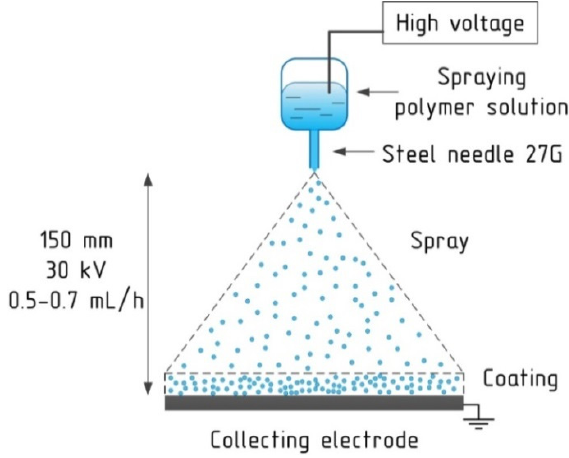
Figure 2. Principal scheme of the electrospraying process and technological parameters.